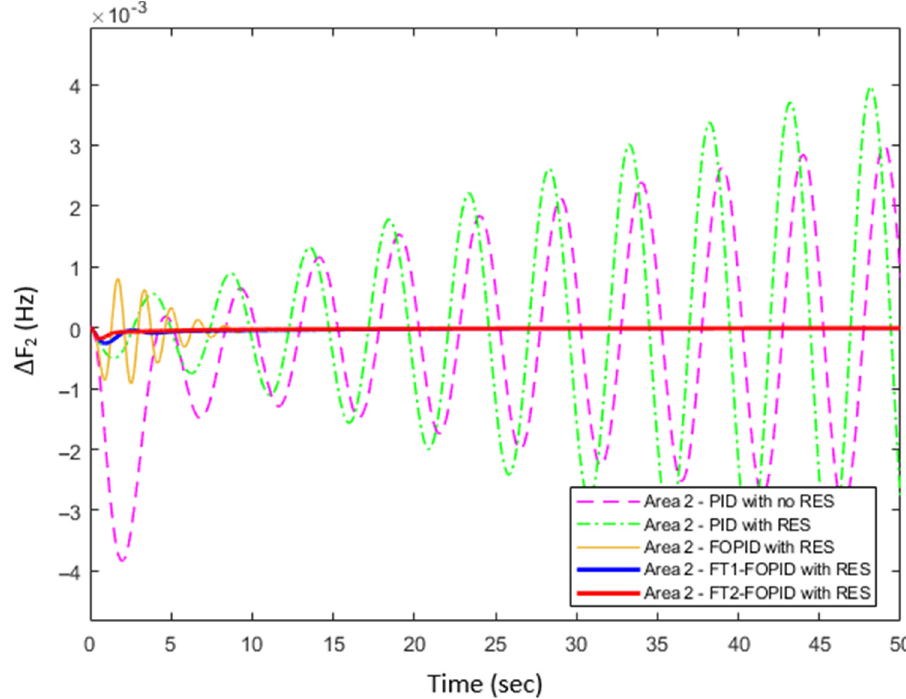
Figure 12. Results for 1% load alteration in Area 2.